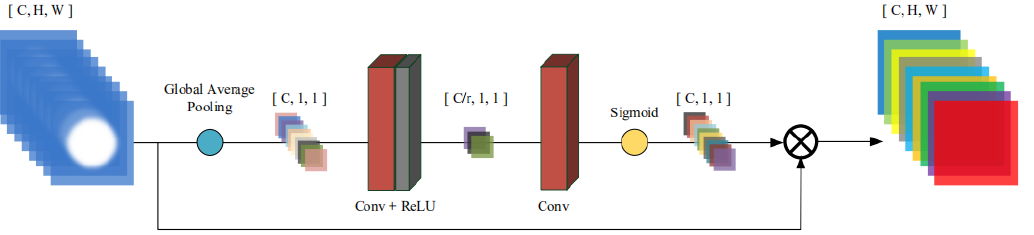
Figure 5. Fusion module.